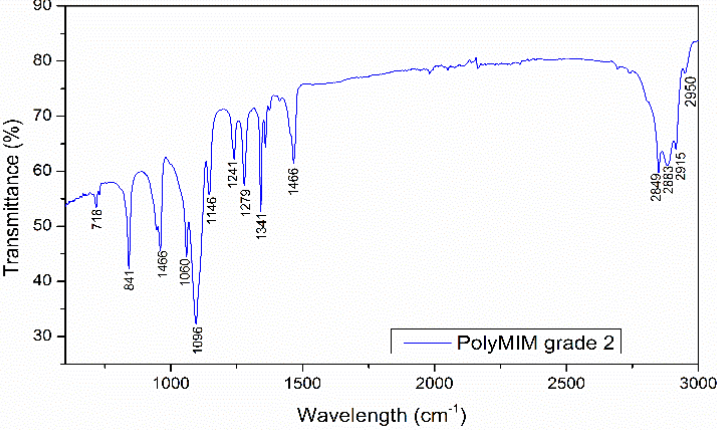
Figure 4. FTIR spectrum of the commercial feedstock.